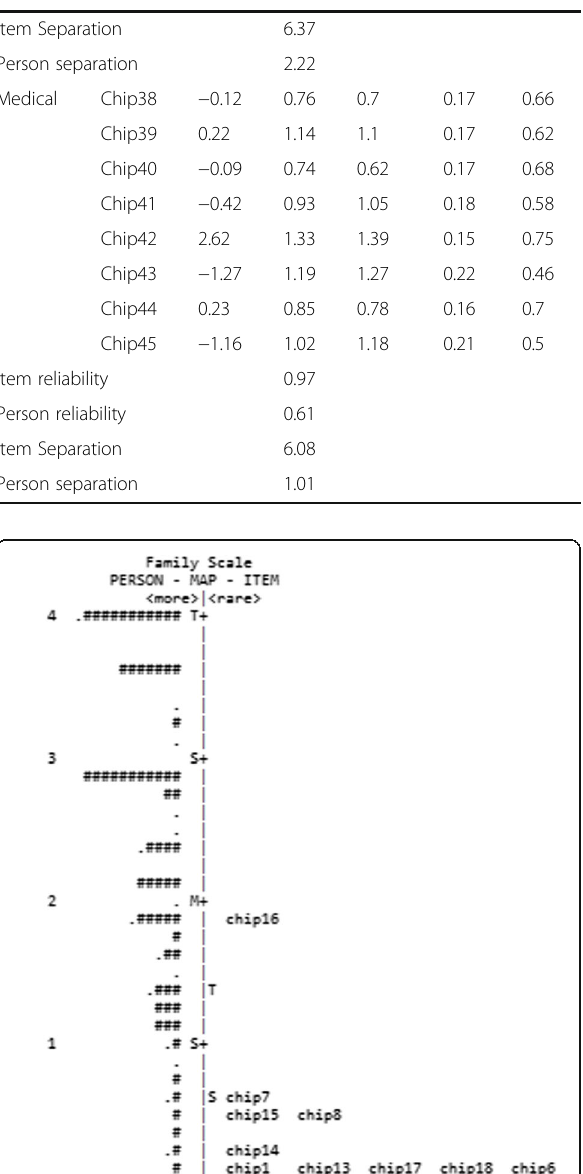
Table 3 Parameters and fit of items to the measurement models for each CHIP subscale ( n = 220)